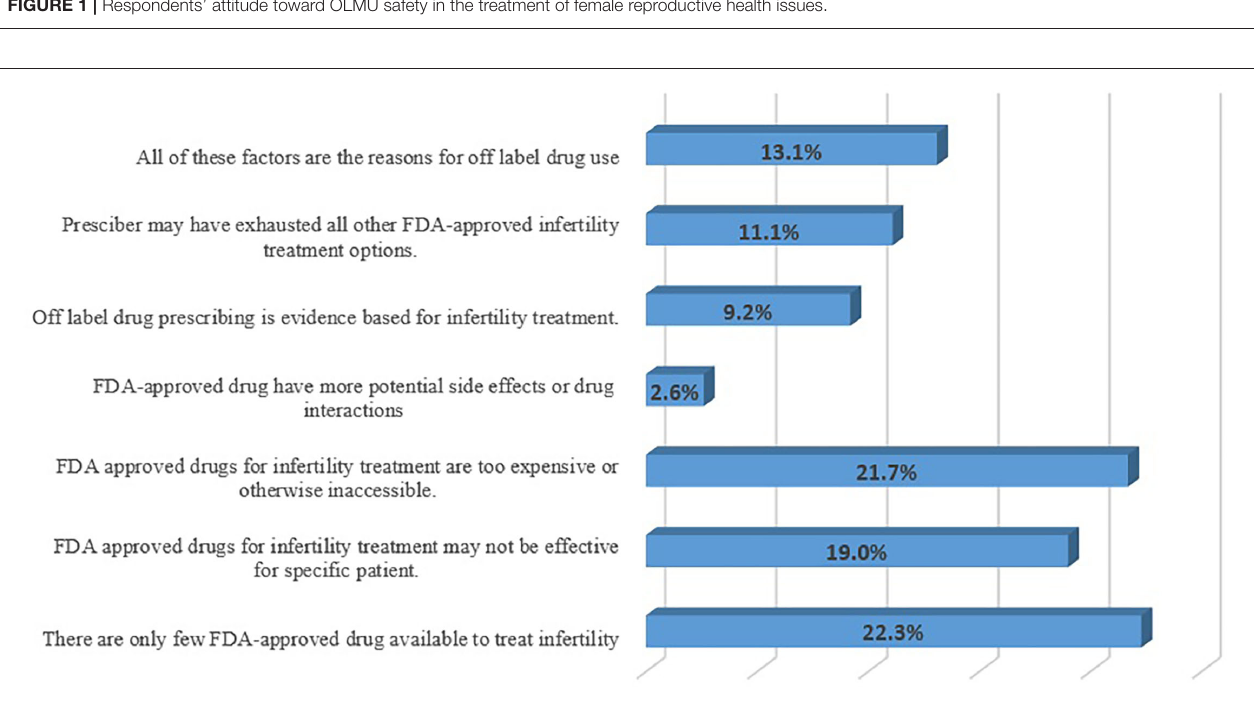
FIGURE 1 | Respondents’ attitude toward OLMU safety in the treatment of female reproductive health issues.